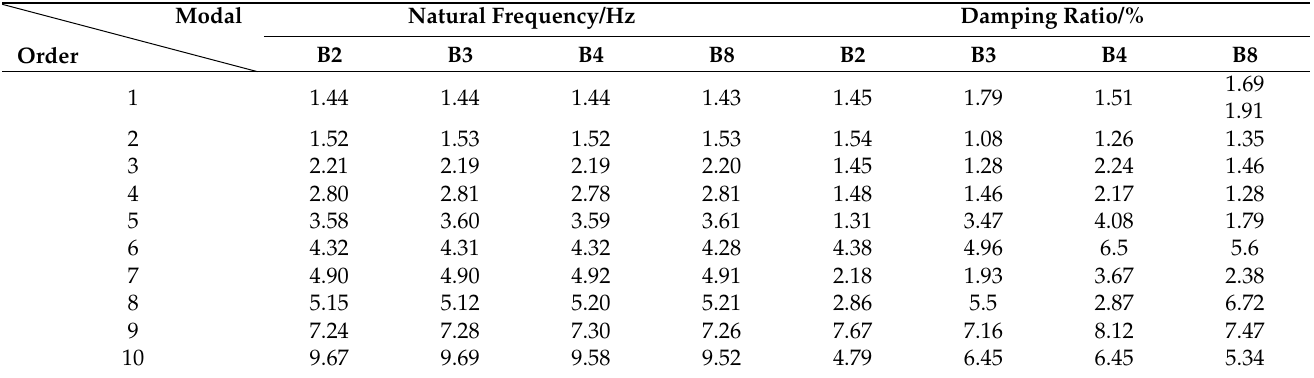
Table 2. Comparison of modal identification results of different measuring points of the high arch dam structure.